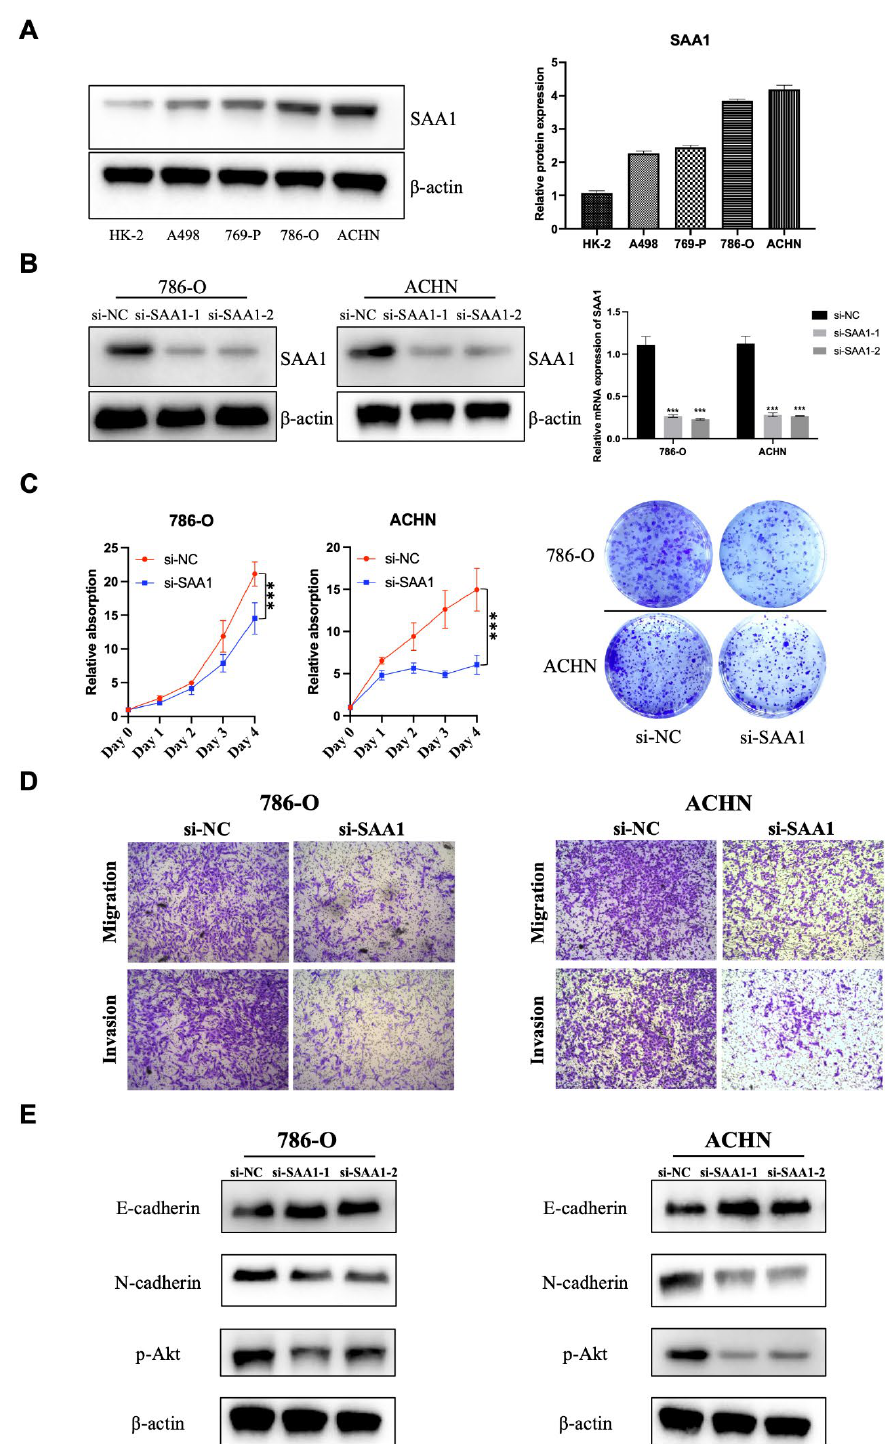
Figure 9. Effect of SAA1 on the proliferation and EMT of ccRCC cells. ( A ) Protein expression of SAA1 in ccRCC cell lines (A498, 769-P, 786-O, and ACHN) and normal renal epithelial cell line (HK-2). ( B ) Knock-down efficiency of si-NC, si-SAA1-1, and si-SAA1-2 was validated by Western blotting and qRT-PCR. ( C ) Cell counting kit-8 assay and colony formation assay were used to detect the proliferation ability of SAA1 knockdown ccRCC cell lines. ( D ) Transwell assay was performed to detect the migration and invasion of ccRCC cells (20 × ). ( E ) Effect of SAA1 knockdown on the expression of EMT-related proteins by Western blotting. Note: *** p <